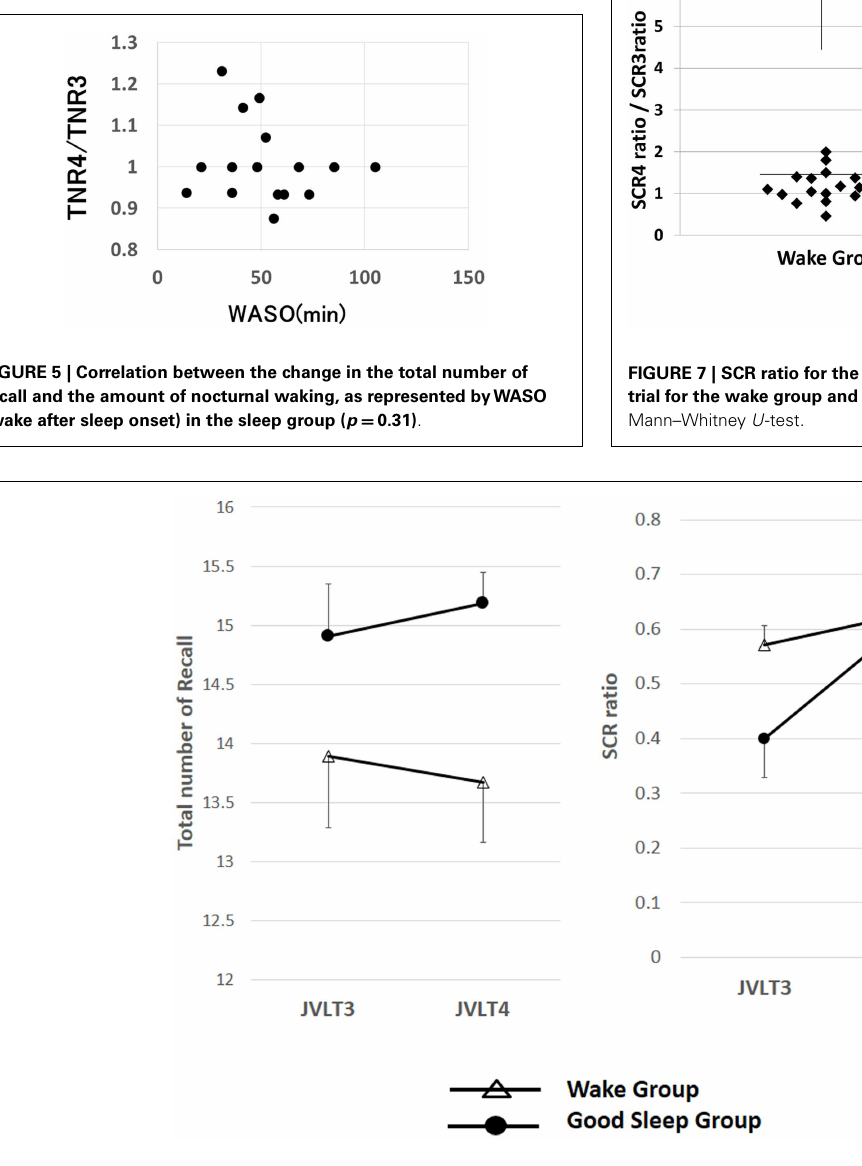
FIGURE 6 |The total number of words recalled (left) and the SCR ratio (right) from the JVLT in the good sleeper group ( n = 11) and control subjects ( n = 15) . Left; repeated measures ANOVA was conducted to see the effect of sleep on the total number of recall with Group [sleepers showing WASO ≤ 60min ( n = 11) vs. awake subjects] as between subject variable, and time as within-subject variable.Time × Group interaction effect was not significant for the total number of words recalled [ F (1, 27) = 0.57, p = 0.46],